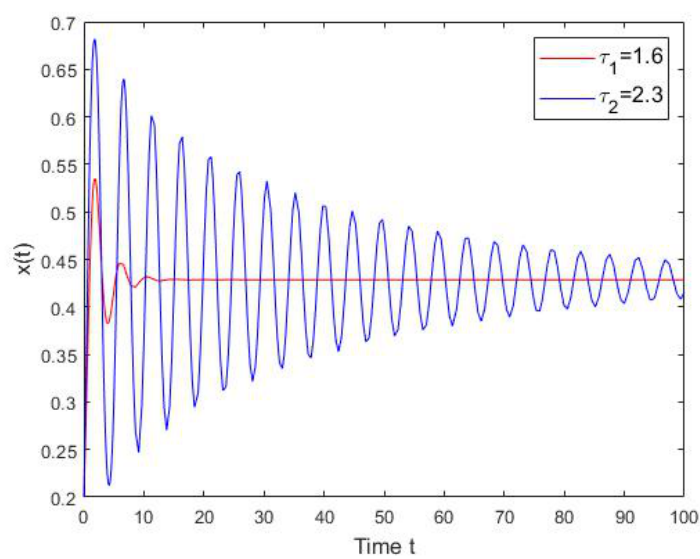
Figure 1. The numerical solution the system in Equation (14), where V = 3 and C = 7.